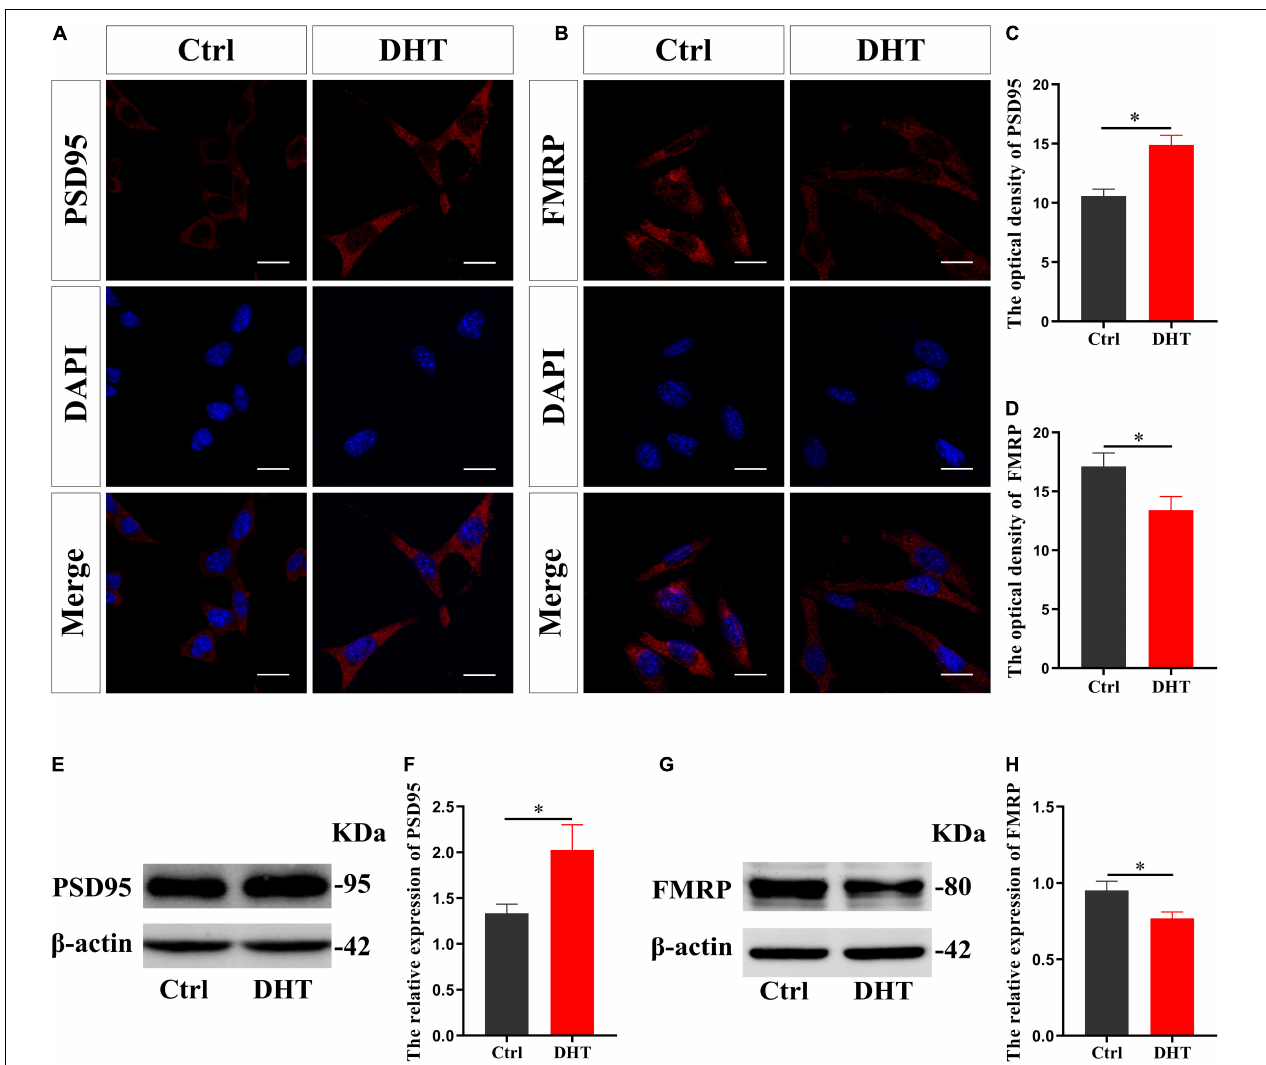
FIGURE 1 | Effects of DHT on PSD95 protein and FMRP in HT22 cells. (A,C) Immunofluorescence cytochemistry for PSD95 expression induced by DHT in HT22 cells. (B,D) Immunofluorescence cytochemistry for FMRP expression induced by DHT in HT22 cells. (E,F) Western blotting for PSD95 expression induced by DHT in HT22 cells. (G,H) Western blotting for FMRP expression induced by DHT in HT22 cells. Scale bars = 20 µ m ( ∗ p < 0.05, n =